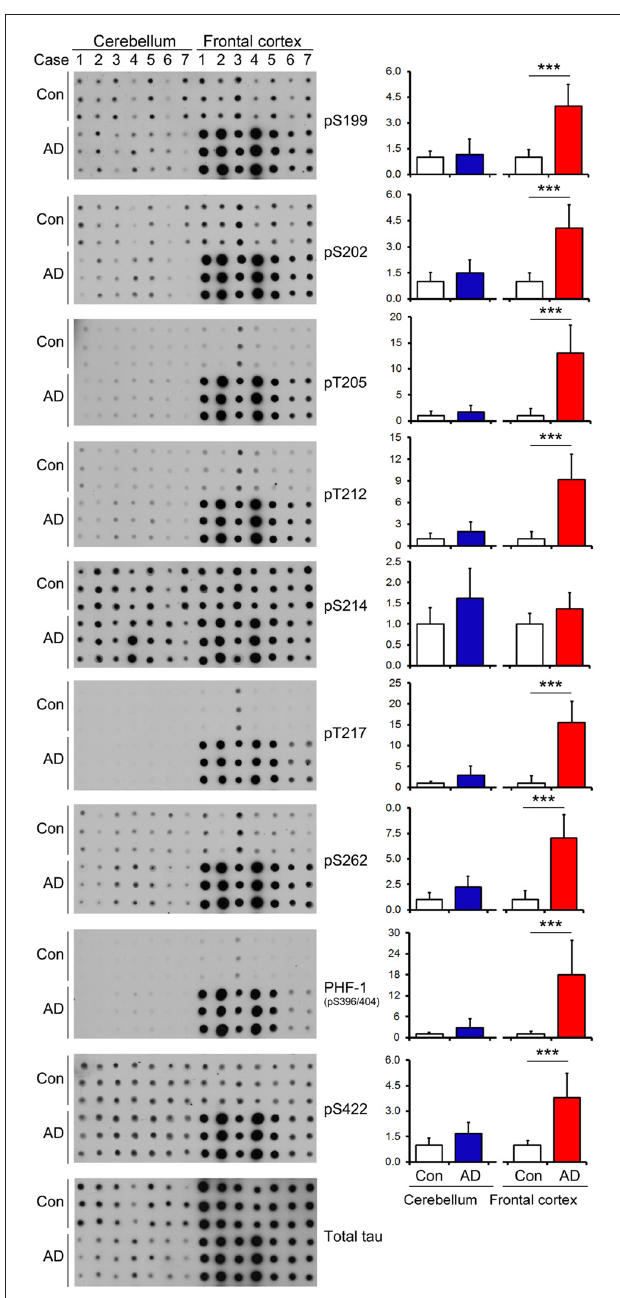
FIGURE 2 | Tau is hyperphosphorylated in the FC but not in the cerebellum of individuals with Alzheimer disease (AD). Same amount of brain crude extract protein from AD and control cases was dotted in triplicates on nitrocellulose membrane and developed with the site-specific and phosphorylation dependent anti-tau antibodies indicated at the right side of the blots. Each bar chart indicates quantitation for the corresponding dot blots to the left; the y axis indicates relative phosphorylation levels of tau at the indicated epitope to respective control (normalized by normal tau). Data are expressed as mean ± SD, n = 7. ∗∗∗ P < 0.001. Con, control; AD, Alzheimer’s disease.